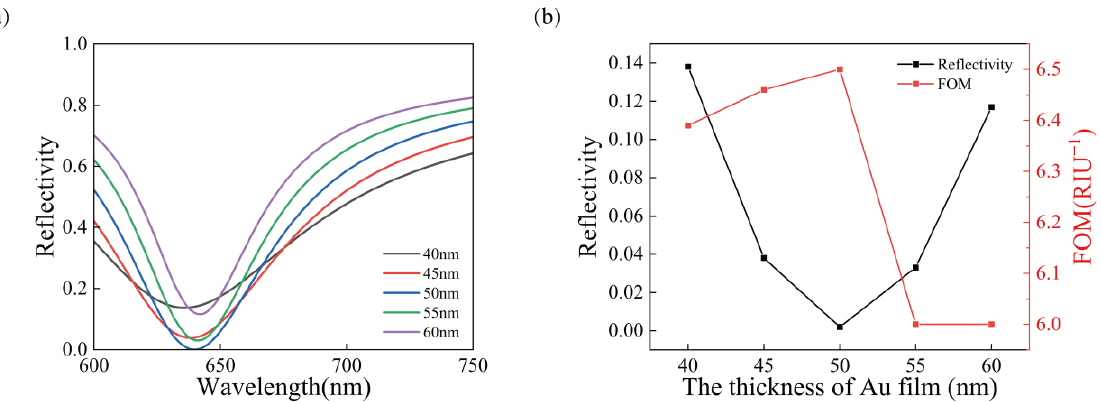
Figure 2. ( a ) SPR curves for the different thicknesses of gold film, ( b ) comparison of reflectivity and FOM at different gold film thicknesses.